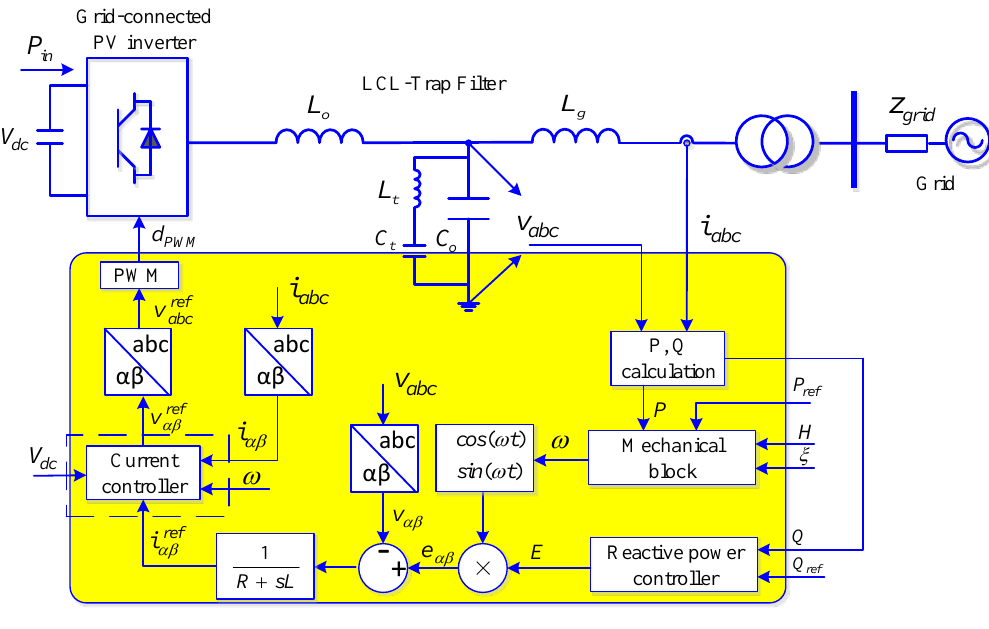
Figure 2. Grid-connected PV inverter controlled by the proportional resonant (PR) current controller and the synchronous power controller